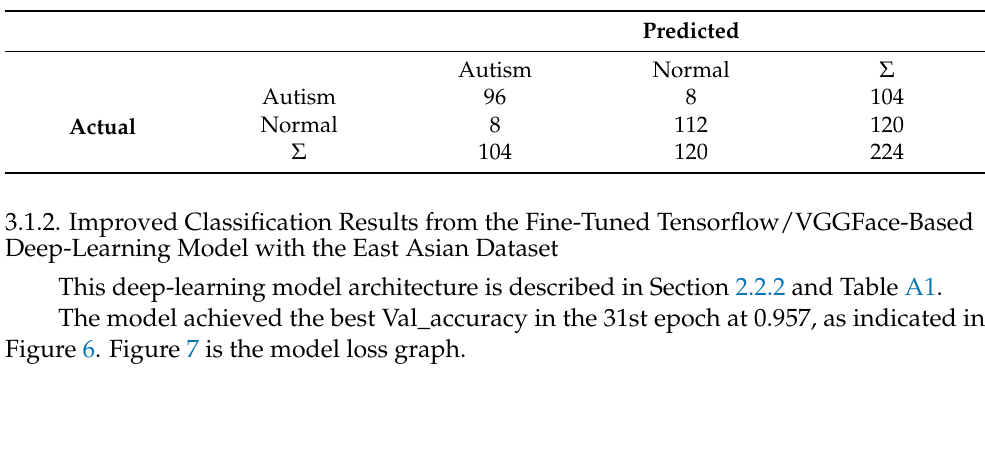
Table 4. Confusion matrix for neural network model trained and tested with the East Asian